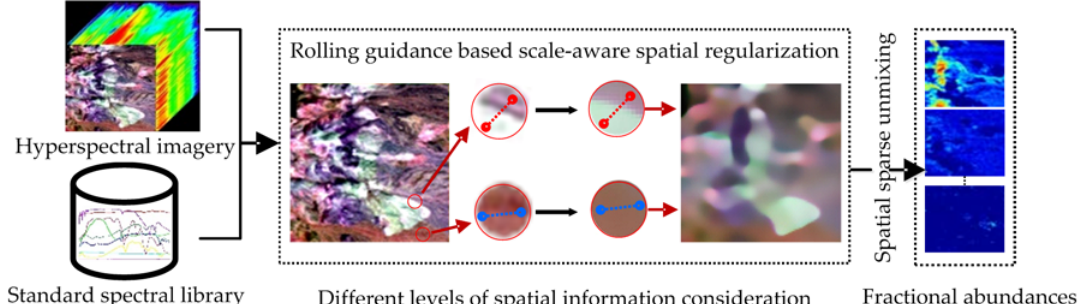
Figure 2. Basic schematic of the proposed Rolling Guidance Sparse Unmixing (RGSU) method.